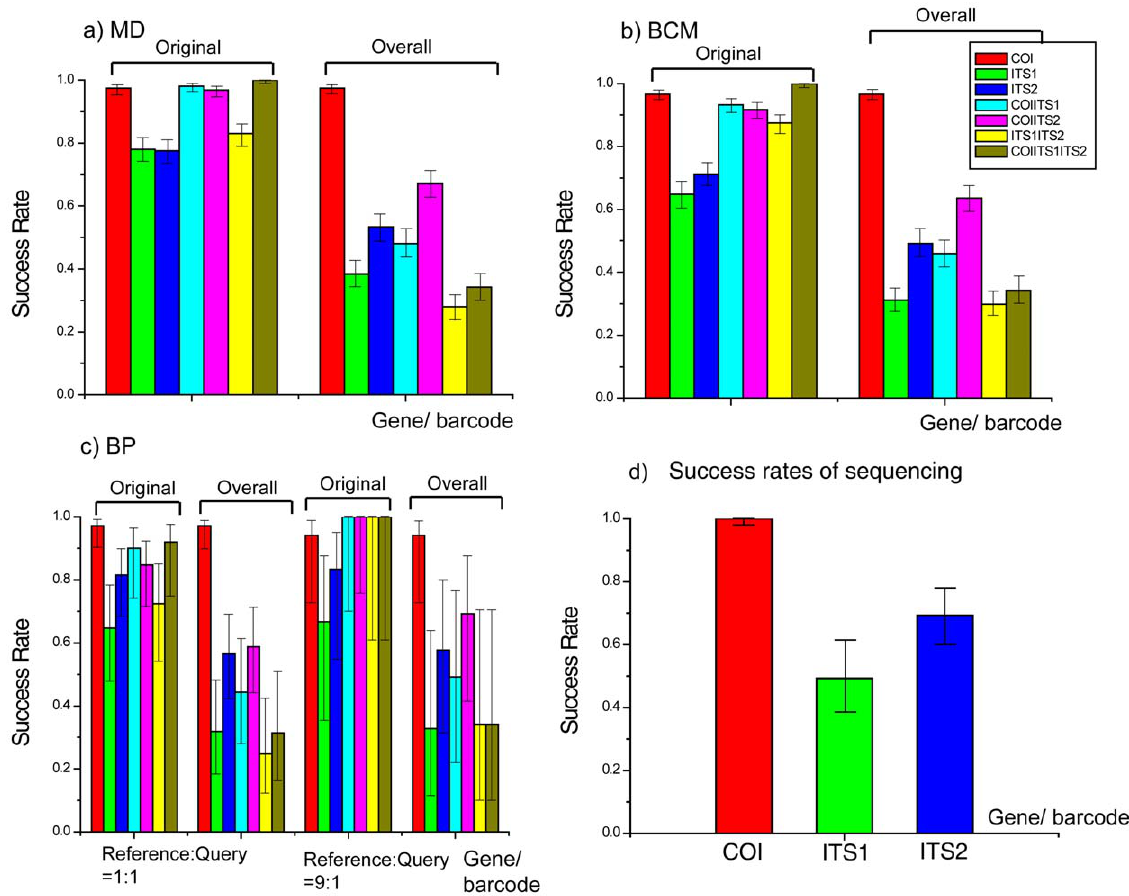
Figure 7. Success rates of species identification based on different gene/barcodes or their combinations for six closely related Dendrolimus pine moth species with distance-based methods and neural network approach [ 52 ] . a) Success rates with MD method [53] based on 500 replications; b) Success rates with BCM method [20] based on 500 replications; c) Success rates with BP-based method [12]; d) Success rates of sequencing for COI, ITS1, and ITS2 genes. Bars with different colors denote different genes/barcodes or their combinations. Vertical solid line with two horizontal short lines indicate 95% confidence intervals of success rates. Bars under ‘‘original’’ and ‘‘Overall’’ mean original success rates and the overall success rates corrected by sequencing success rates respectively (see text for